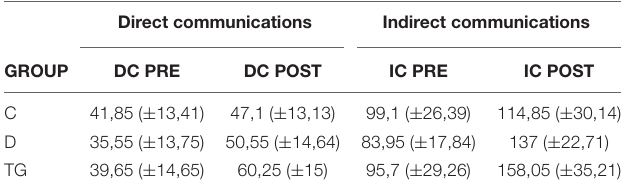
TABLE 4 | Means and standard deviations of the number of direct and indirect communications for the PRE and POST measures for the three groups.